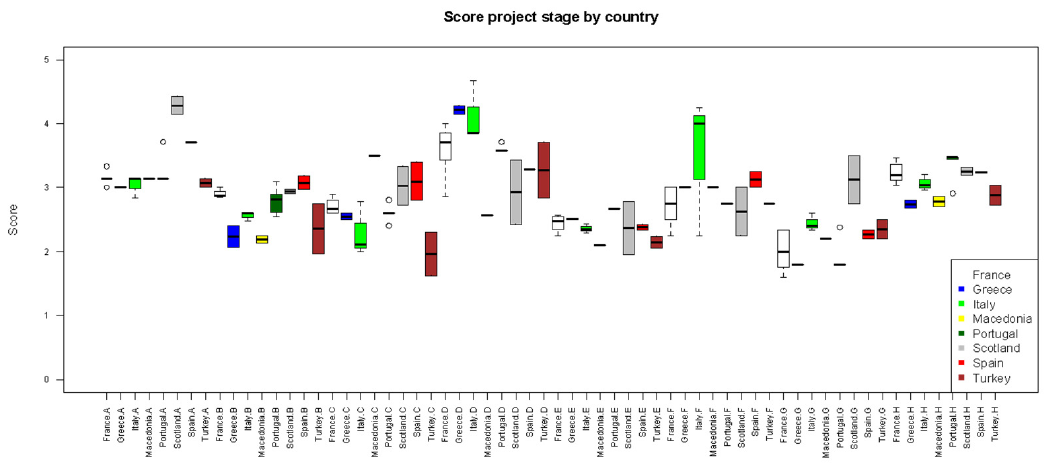
Figure 10. Differences between the average sustainability performance per project stage and country where the project is based in. The lower edge of the box corresponds to the 25th percentile data point, while the top edge of the box corresponds to the 75th percentile data point. The line within the box represents the median. The highest and lowest scores excluding outliers are shown in the upper and lower whiskers. Instances where only the median bar and outliers are portrayed denote a small dataset from which the statistical distribution could not be drawn.